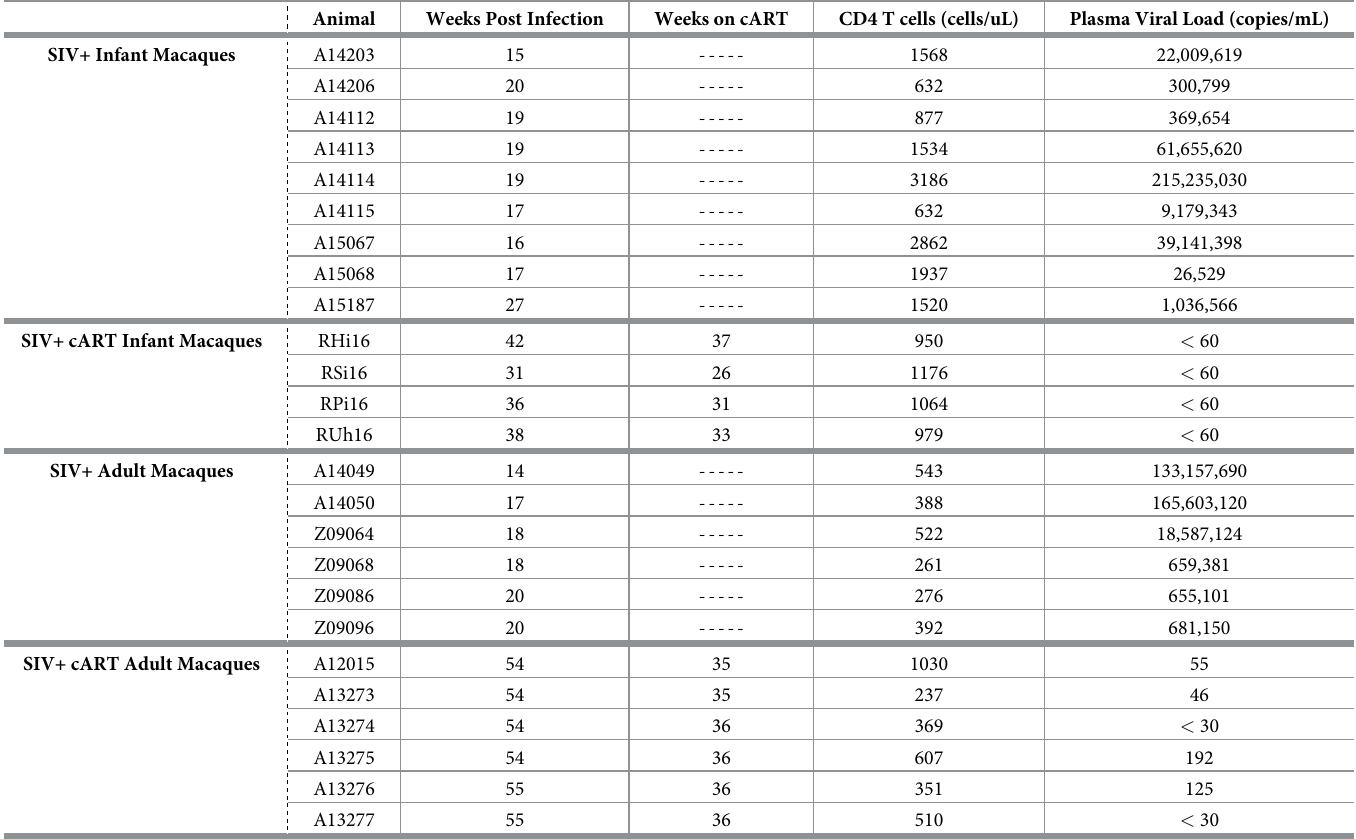
Table 5. Characteristics of SIV-infected